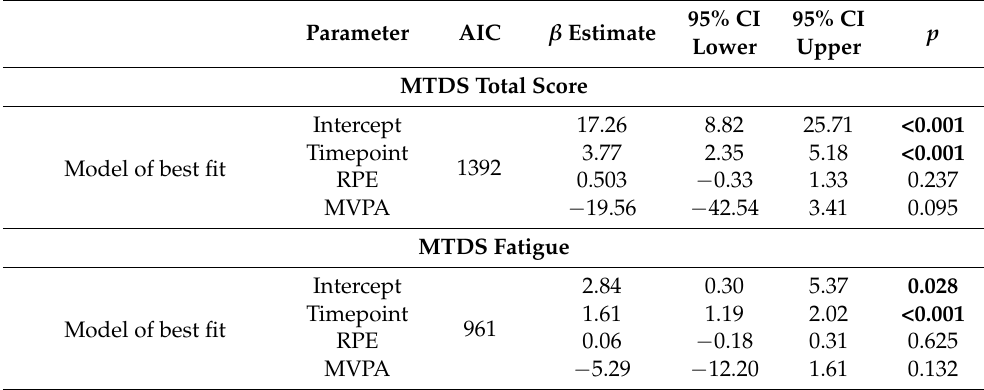
Table 1. Parameters of multi-level linear models of best fit, and significant single measure relation- ships for energy expenditure, MVPA and RPE with MTDS.